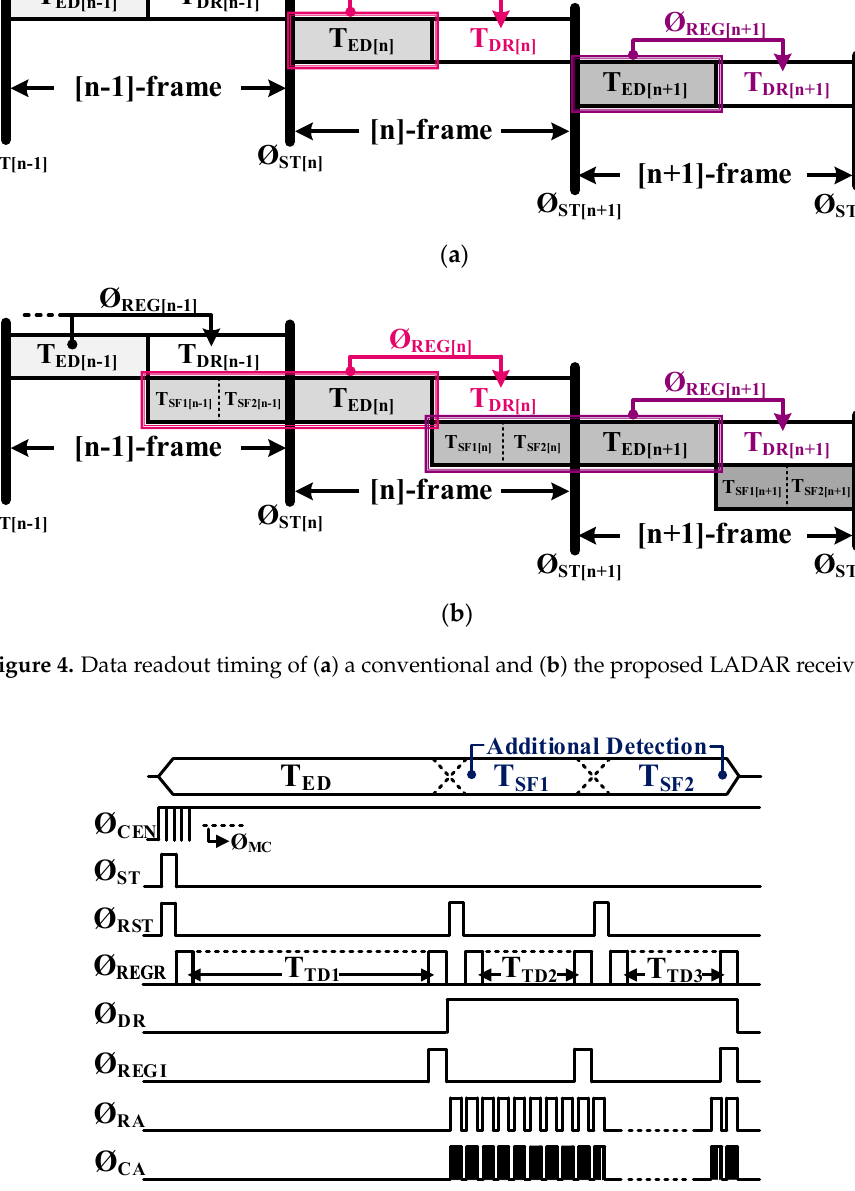
Figure 4. Data readout timing of ( a ) a conventional and ( b ) the proposed LADAR receiver.